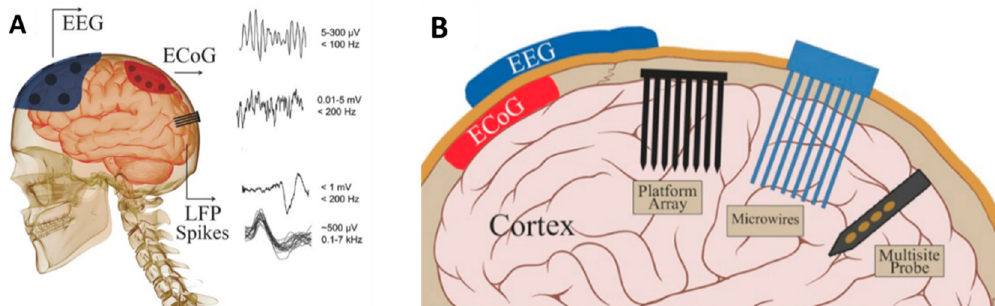
Figure 3. Schematic of ( A ) neural signals (EEGs, ECoGs, LFPs, and spikes) and their properties. ( B ) EEG electrode on the skull, ECoG electrode on the surface of brain, and penetrating electrodes: three main types of intraparenchymal (intracortical) sensors now in use are illustrated: platform array, an array of electrodes emanating from a substrate that rests on the cortical surface; multisite probe, with contacts along a flattened shank; and microwire assemblies, consisting of fine wires (reproduced here from [74] with copyright permission).